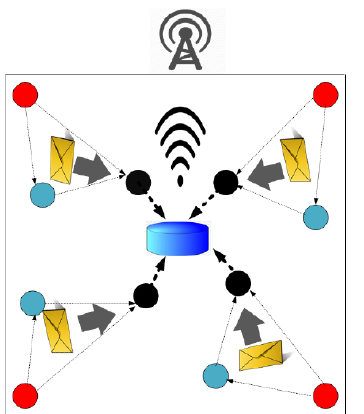
Figure 19. Cooperative forwarding.